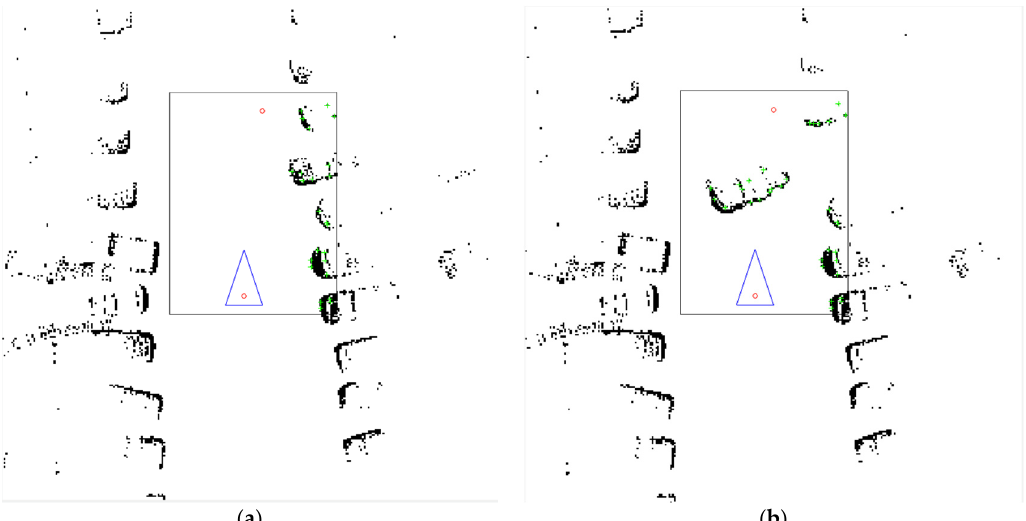
Figure 9b. This group of points calculated by the Harris algorithm are called keypoints (KP i ) and will be used in the next stage of the PPS to create a set of trajectories.